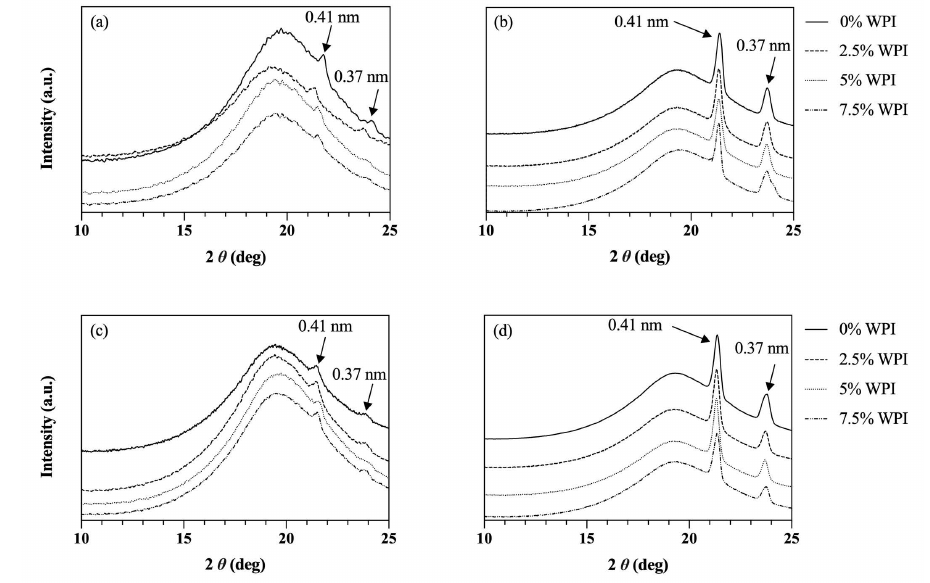
Figure 6. XRD spectra of the colloidal gels prepared with varying WPI and RBW content: ( a ) the OG (0% WPI) and OCs made with 1% RBW, ( b ) the OG (0% WPI) and OCs made with 10% RBW, ( c ) the HOG (0% WPI) and HOCs made with 1% RBW, and ( d ) the HOG (0% WPI) and HOCs made with 10%